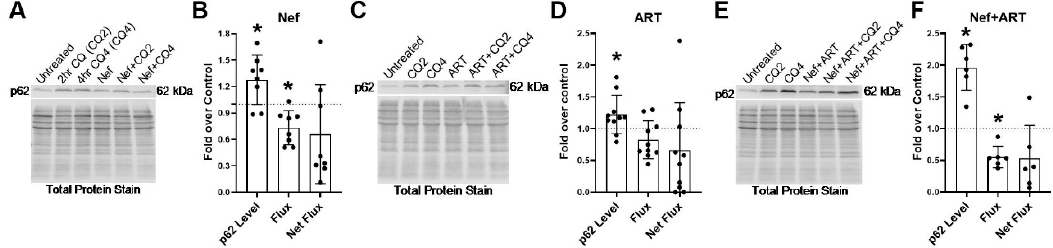
Figure 6. p62 lysosomal degradation after treatment with Nef and / or ART for 7 days. Primary human astrocytes were treated with extracellular Nef and / or ART daily for 7 days, without and with chloroquine (CQ) for the last 2 or 4 h, after which p62 Western blotting was performed. Steady-state level, flux and net flux for p62 were calculated as described in Methods. ( A , C , E ) Representative p62 Western blots after A. Nef, C. ART, or E. Nef + ART treatment. ( B , D , F ) show the fold changes of autophagy parameters after B. Nef, D. ART, and F. Nef + ART treatment over control of individual experiments (dots) and the means of the fold changes of the experiments (bars). Controls were set to 1, represented by the dashed lines. Error bars depict SD. n = 6–10; *, p < 0.05; by the Wilcoxon Signed Rank test.